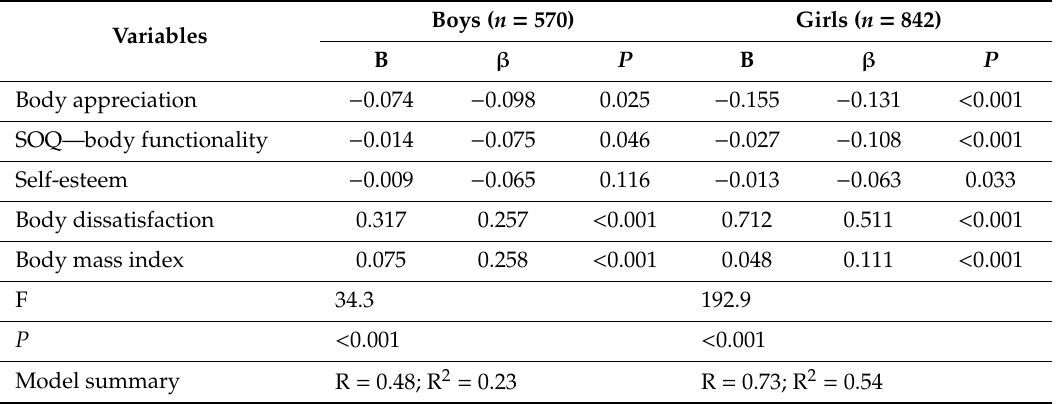
Table 6. Results of multiple linear regressions predicting disordered eating behaviors in adolescent boys and girls (the adolescent sample, n =